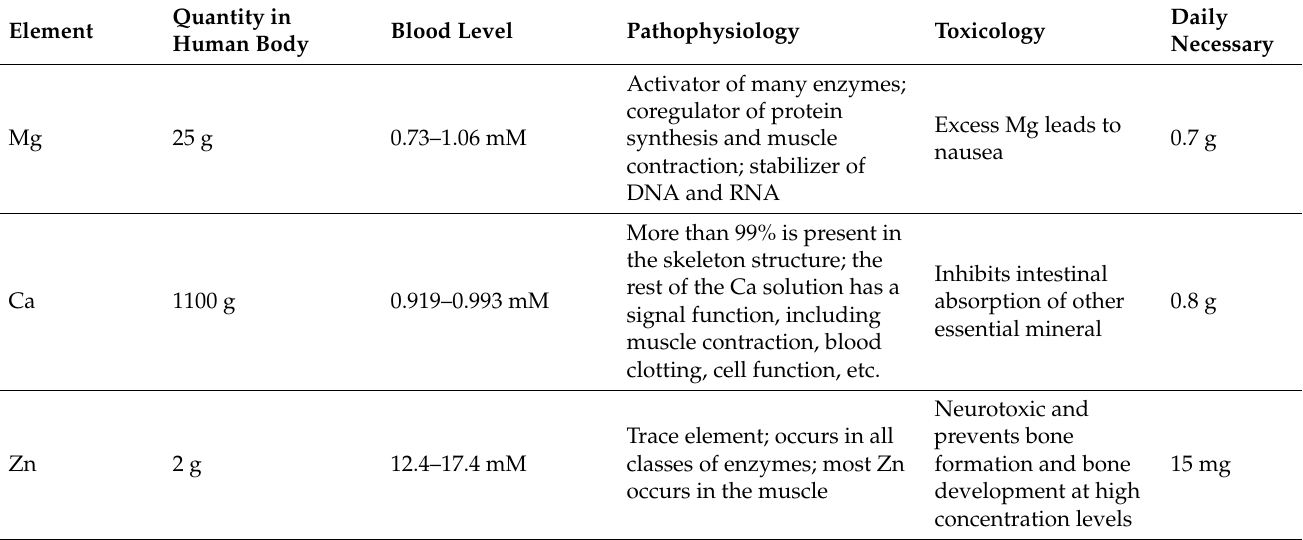
Table 3. Toxicological influence of Mg, Ca, and Zn in the human body used as alloying elements